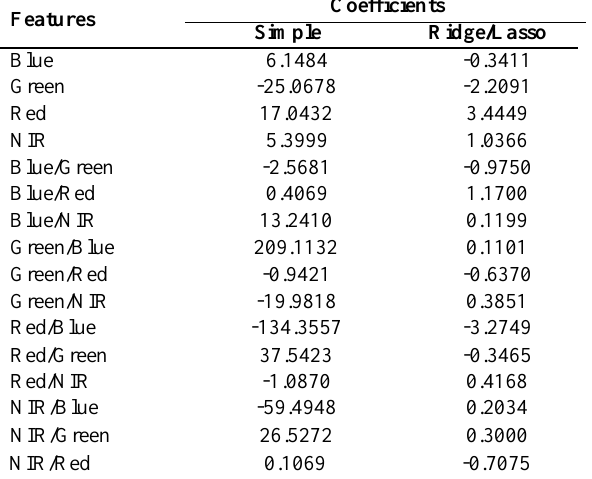
Table 2. Coefficients of the Linear Models (Ridge and Lasso have the same coefficients). The coefficients of Simple Linear